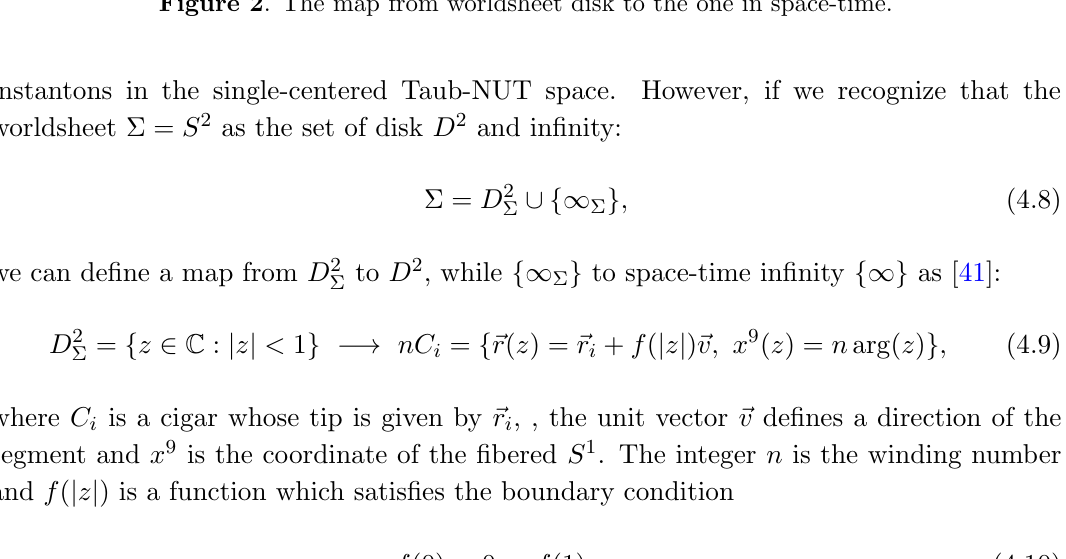
Figure 2 . The map from worldsheet disk to the one in